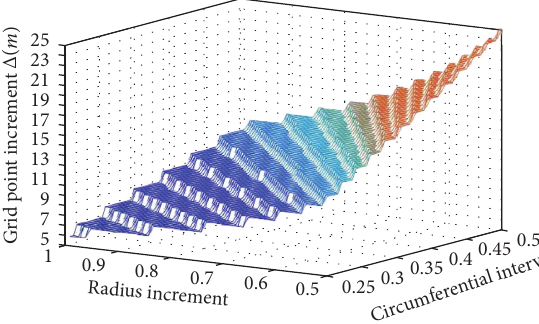
Figure 3: Relations among grid point increment Δ m , radius in- crement Δ 􏽥 ρ , and circumferential interval 􏽥 d